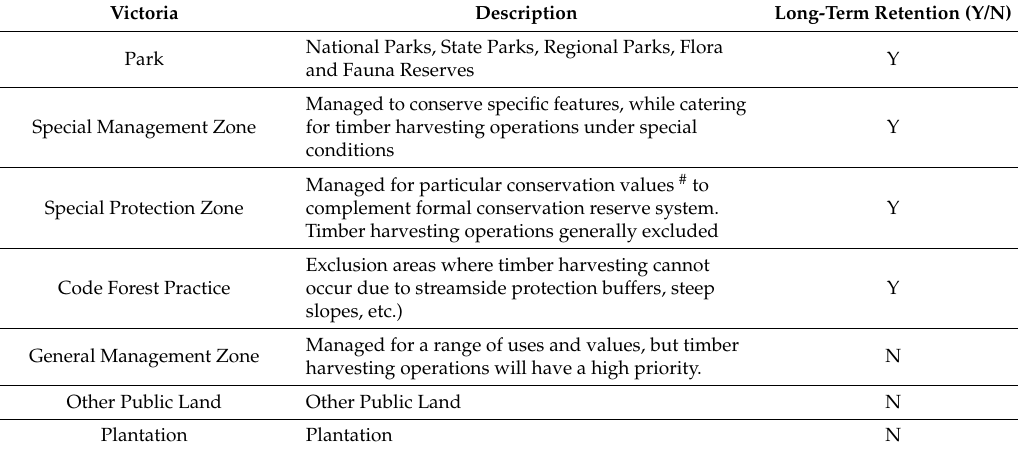
Table A2. Tenure types in public native forest in public native forests in Victoria. Categories included in long-term retention are highlighted in italics. Based on the Forest Management Zone spatial layer described in